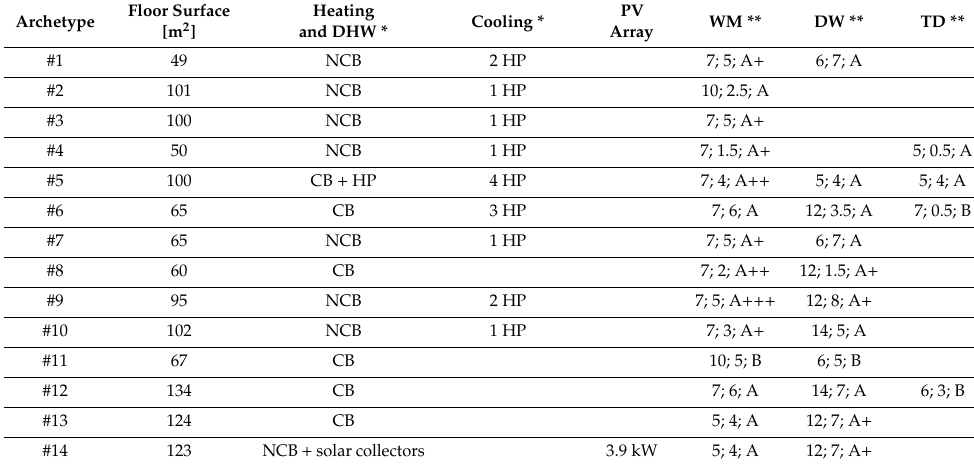
Table 2. Archetypes appliances and characteristics.